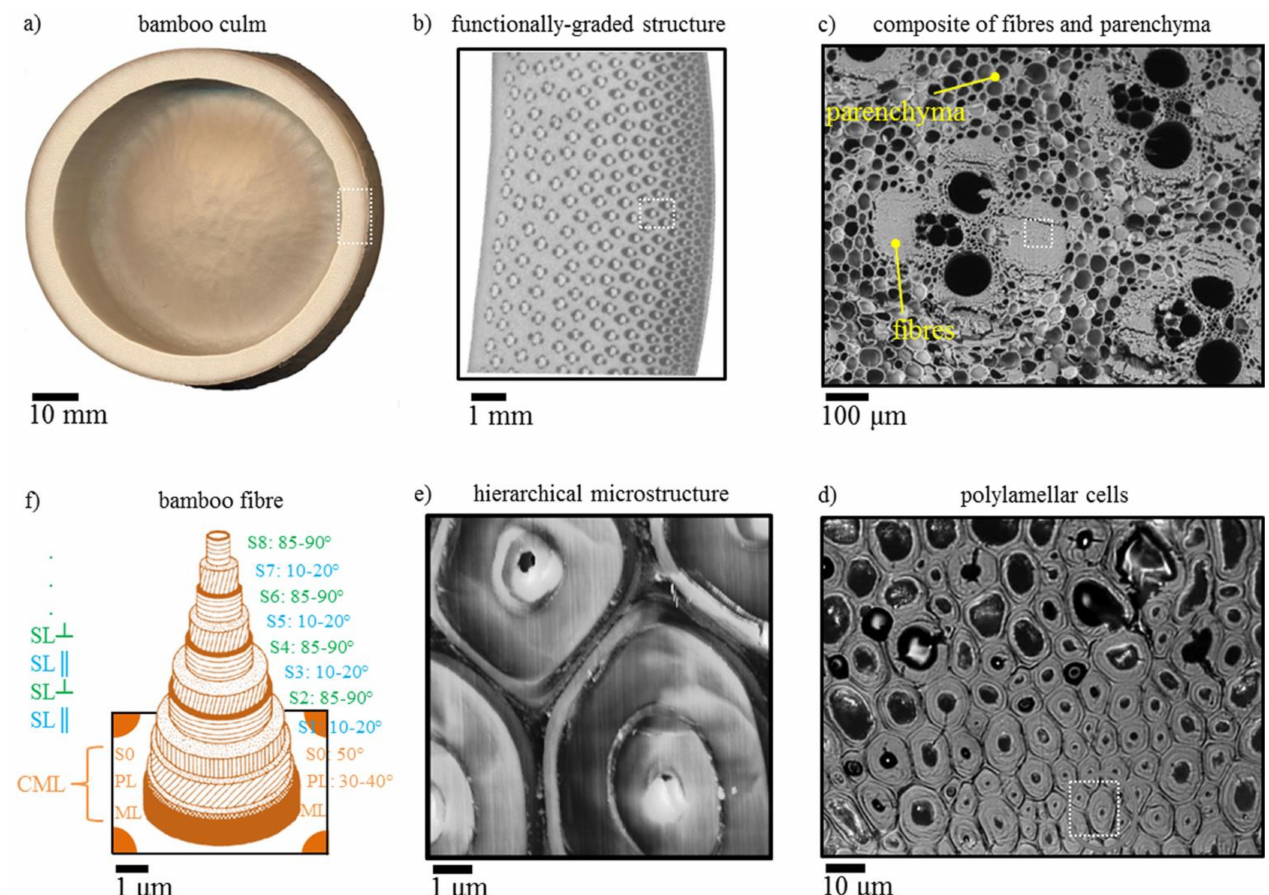
Figure 7. ( a ) Bamboo culm, ( b ) bamboo culm cross-section, ( c ) vascular bundle, ( d ) polylamellar cells, ( e ) microstructure fibers, and ( f ) bamboo’s model of polylamellae structure. Extracted with permission from Ref.